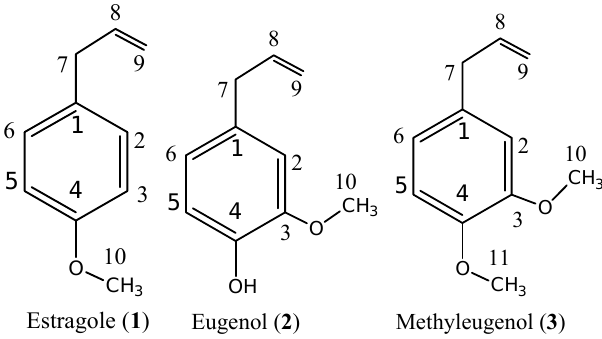
Figure 1. Constituent compounds isolated from the essential oil of Agastache rugosa aerial